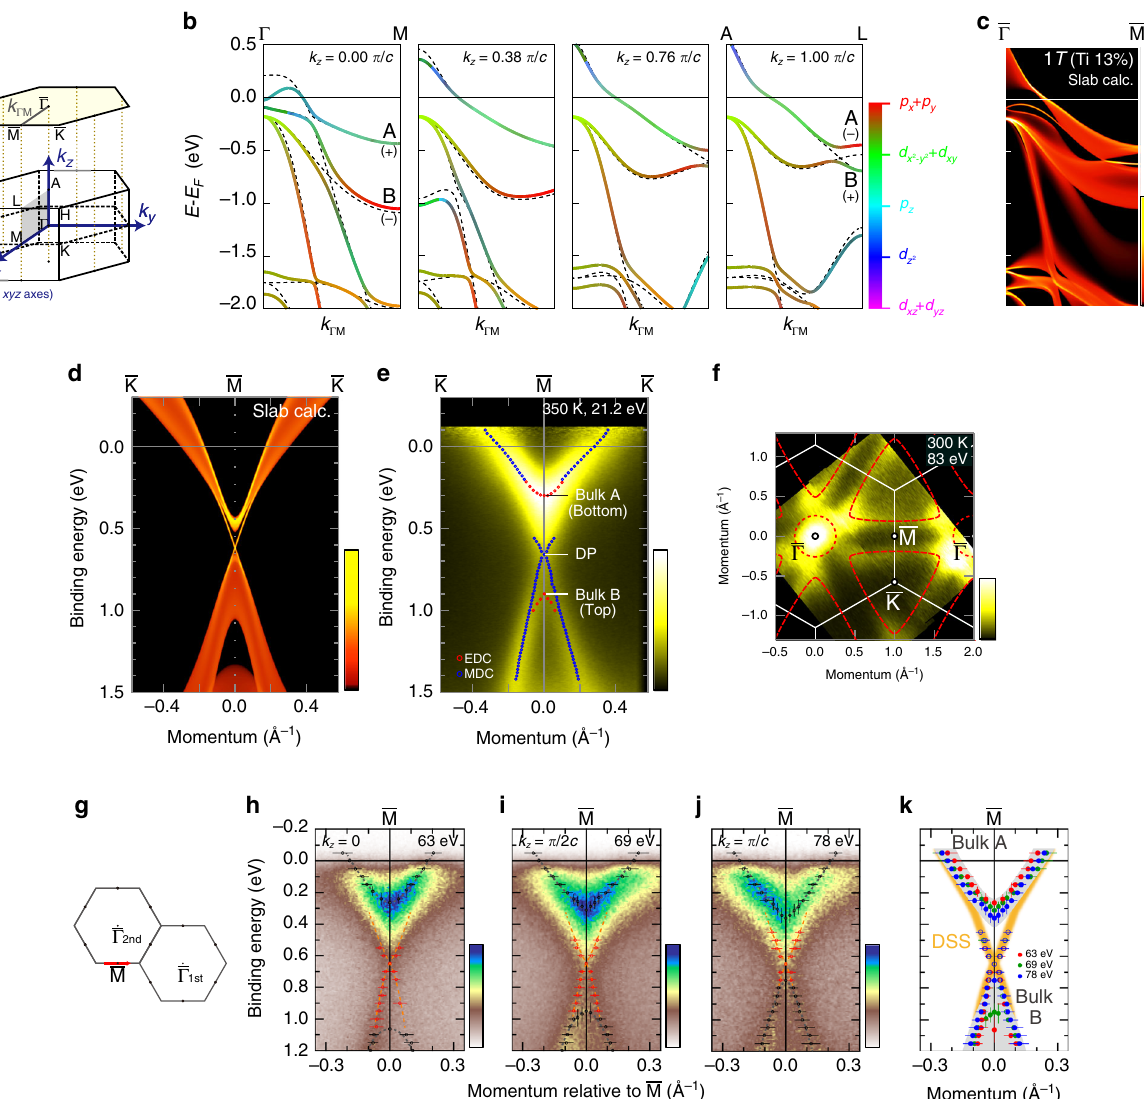
Fig. 4 Topological character of band structures in the normal 1 T phase for Ti-doped VTe 2 . a The Brillouin zone of 1 T phase. k x , k y , and k z indicate the axes in the reciprocal space corresponding with the global xyz axes (see Fig. 1a) used for the calculation in b . b The bulk band calculations of 1 T - V 0.87 Ti 0.13 Te 2 along k Γ M direction at several k z values (0, 0.38, 0.76, 1.00 π / c ). The color of the curves indicates the weight of orbital characters, as shown by the color-scale. The “ + ” and “ − ” mark the even and odd parity, respectively. The broken curves represent the results without spin-orbit coupling. c , d The corresponding (0 0 1) slab calculations along the (cid:1) Γ (cid:1) (cid:1) M ( c ) and the (cid:1) K (cid:1) (cid:1) M (cid:1) (cid:1) K ( d ) lines, respectively. e ARPES image of 1 T -V 0.90 Ti 0.10 Te 2 along the (cid:1) K (cid:1) (cid:1) M (cid:1) (cid:1) K direction recorded using a He-discharge lamp (21.2 eV, 350 K). The red (blue) marks represent the peak positions of energy (momentum) distribution curves. f Fermi surface image of 1 T -V 0.87 Ti 0.13 Te 2 in the k z = 0 plane (circular polarized 83 eV photons, 300 K), with an energy window of ±5 meV. The red curves display the Fermi surface schematically. g Schematic 2D BZ. The red arrow indicates the measurement region of h ν - dependent ARPES. h – j h ν -dependent ARPES spectra of 1 T -V 0.90 Ti 0.10 Te 2 with 63 eV ( h ), 69 eV ( i ), and 78 eV ( j ) photons (circular polarization, 320 K), which respectively detects at k z = 0, π /2 c , and π / c plane. The circles with vertical (horizontal) error bars represent the EDC ’ s (MDC ’ s) peak positions. k Schematic band dispersion along (cid:1) K (cid:1) (cid:1) M (cid:1) (cid:1) K with experimentally obtained peak plots. The red, green, and blue markers are the peak plots for h ν = 63, 69, and 78 eV, respectively from h – j . The orange curve represents the schematic of the Dirac surface state (DSS), whereas the blurred gray curves are the bulk bands (Bulk A and (cid:1) Similarly to the normal phase, h ν -dependent ARPES measure- M point (i.e., Dirac crossing point), similarly to the topological 1 ment is performed on the CDW state VTe 2 (15 K, multi-domain) surface state in the topological insulators. On the other hand, the (cid:1) to clarify the k z -dependence of electronic structures. Figure 5j – l M side indeed show the bulk fl at bands around E B ~ 0.25 eV at 2 (cid:1) = (cid:1) M points (see the red displays the ARPES image near the M spin degenerate character. Figure 5i is an expanded viewgraph of 1 2 arrow in Fig. 5f), recorded with h ν = 54, 61.5, and 69 eV, spin-resolved spectra near the Fermi level at emission angle θ = respectively. Again by comparing with the single-domain ±4°. There are slight spin-up/down intensity contrasts just below (cid:1) (cid:1) or M measurement, we can assign the peaks to either M E F ( E B ~ 0.05 eV), which should be corresponding to the upper 1 2 (cid:1) side (see Supplementary Note 9). Figure 5m, n respectively shows side. branch of the surface Dirac cone band at M 1